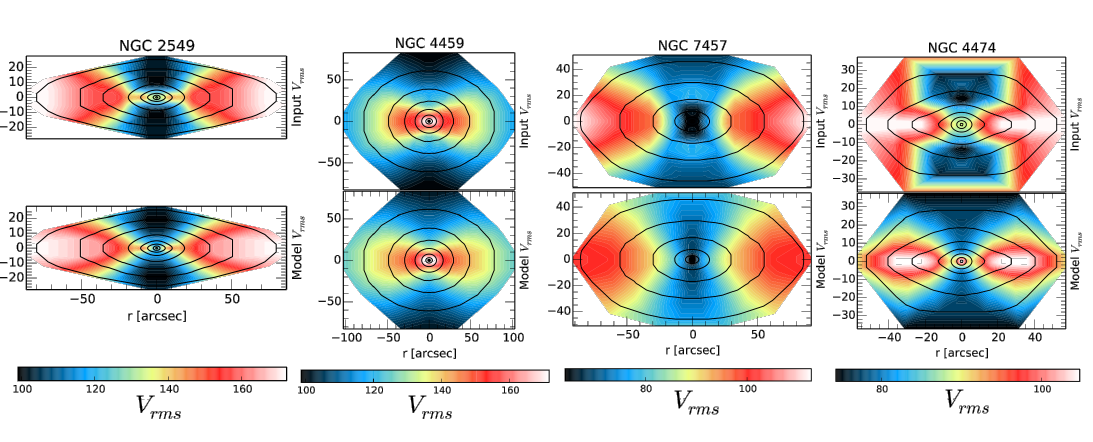
Figure 4. Preliminary JAM V rms maps of four lenticular galaxies of the SLUGGS survey.